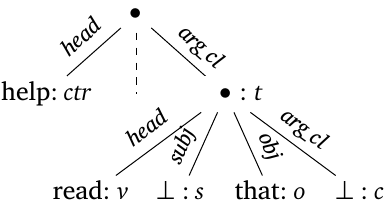
Instantiation of the logical constraints for the last occurrence of p